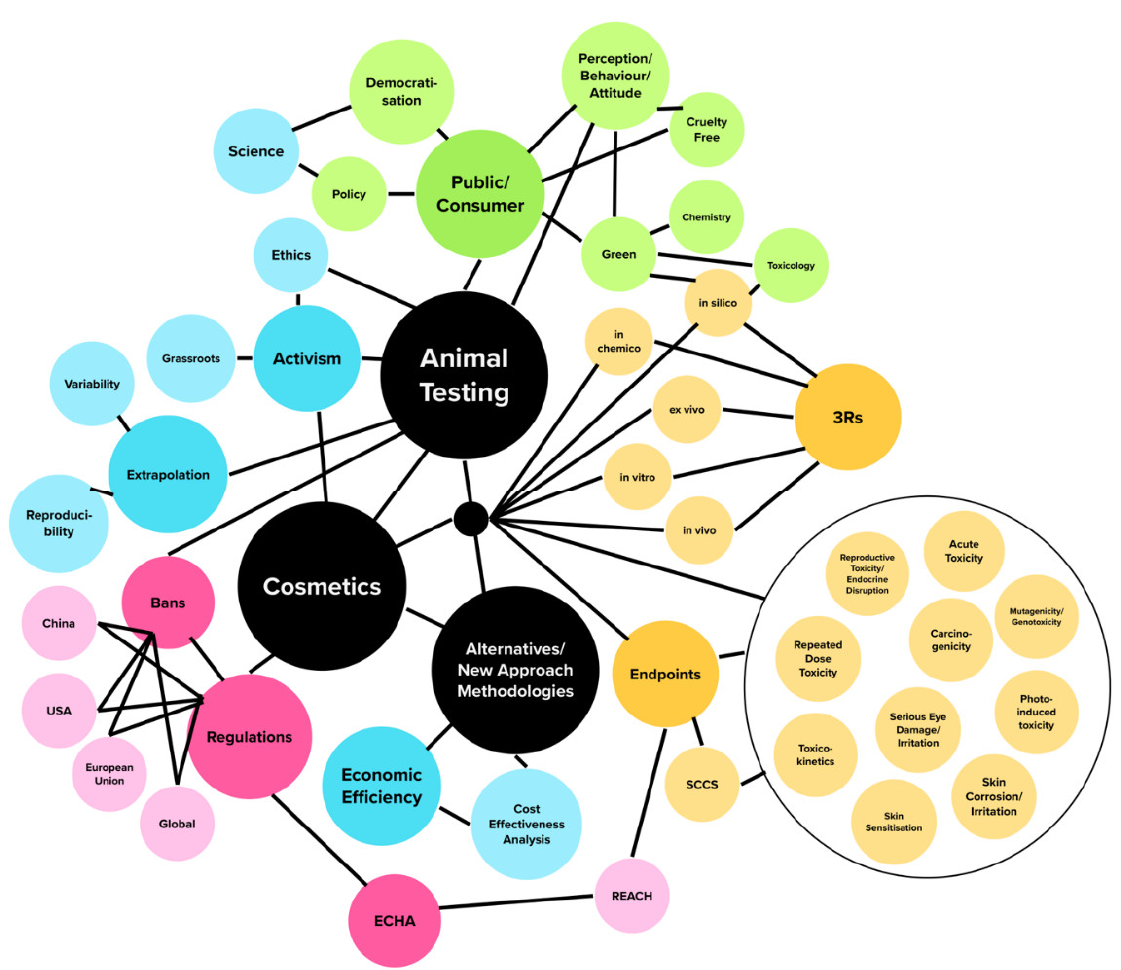
Figure 1. A mind map of the search terms.